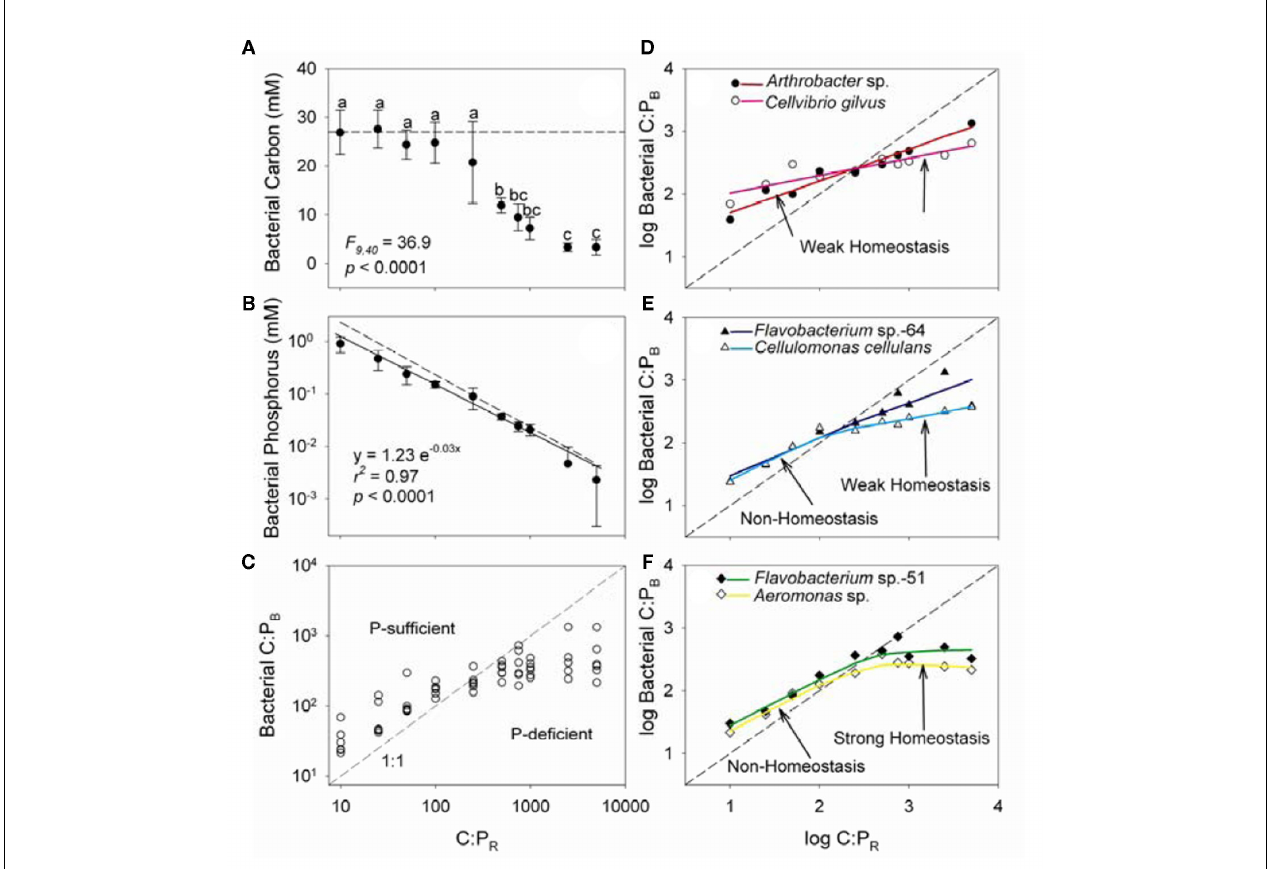
resource C:P, (D) Weak or no homeostasis during P sufficiency, but weak homeostasis during P deficiency, and (E) No homeostasis during P sufficiency, but strong homeostasis during P deficiency. Dashed lines in (A,B) represent the culture dissolved organic C and dissolved P concentrations, respectively. Replicates at each level of resource C:P in (A,B) represent one observation from each cultured isolate. Dashed lines in (C–F) represent the 1:1 slope